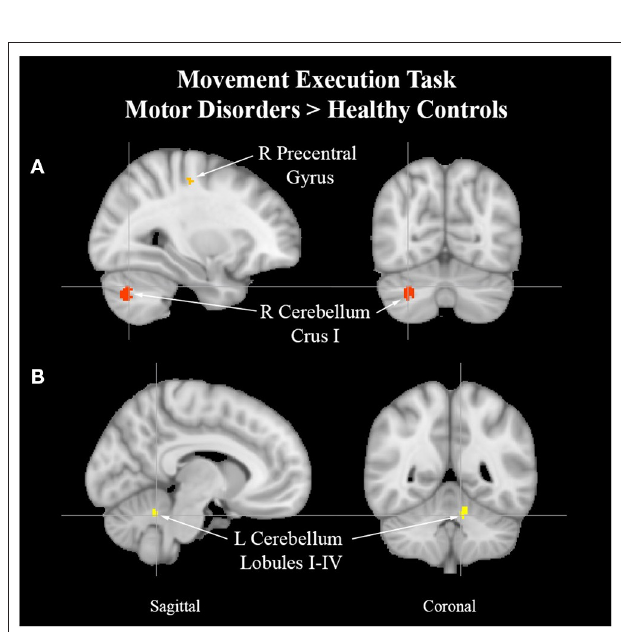
FIGURE 4 | Cerebellum activation peaks in MAP cohort. Exemplar of between-group activation peaks of the movement execution contrast MAP > HC. A. Orange-colored region shows increased brain activity in the right precentral gyrus. Red-colored regions show increased brain activity in the right cerebellum Crus I (cross-hairs reflect activation peak x = 30, y = − 68, z = − 32). B. Yellow-colored regions show increased brain activity in the left cerebellum lobules I–IV (cross-hairs reflect activation peak x = − 8, y = − 50, z = −